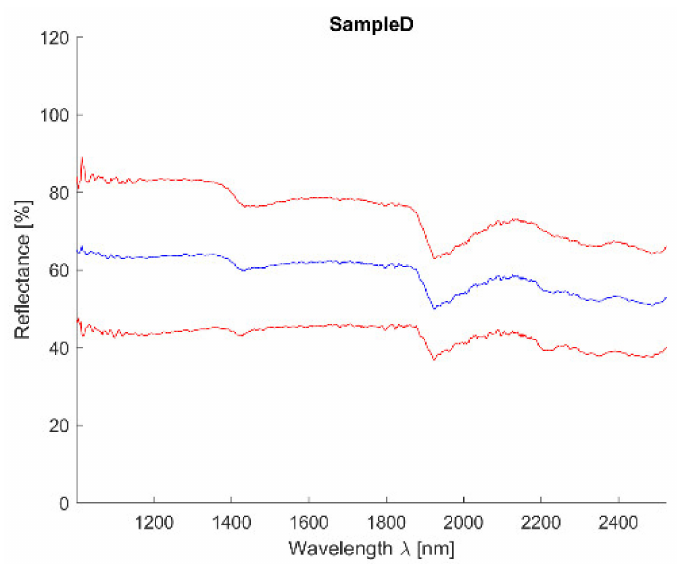
Figure 19. Sample D—all measurements plot. Measurements were taken uniformly all over the sample to cover all possible sample deviations.